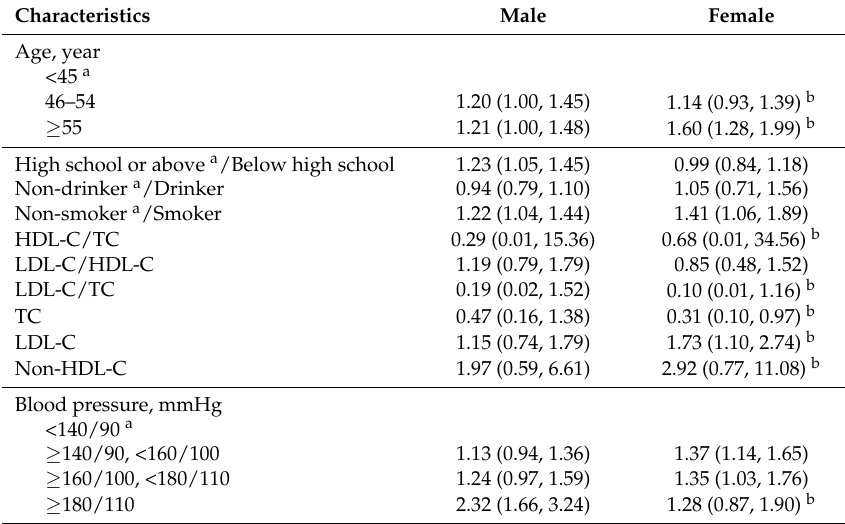
Table 5. Relationship between hs-CRP concentrations and the corresponding cardiovascular risk factors by gender.